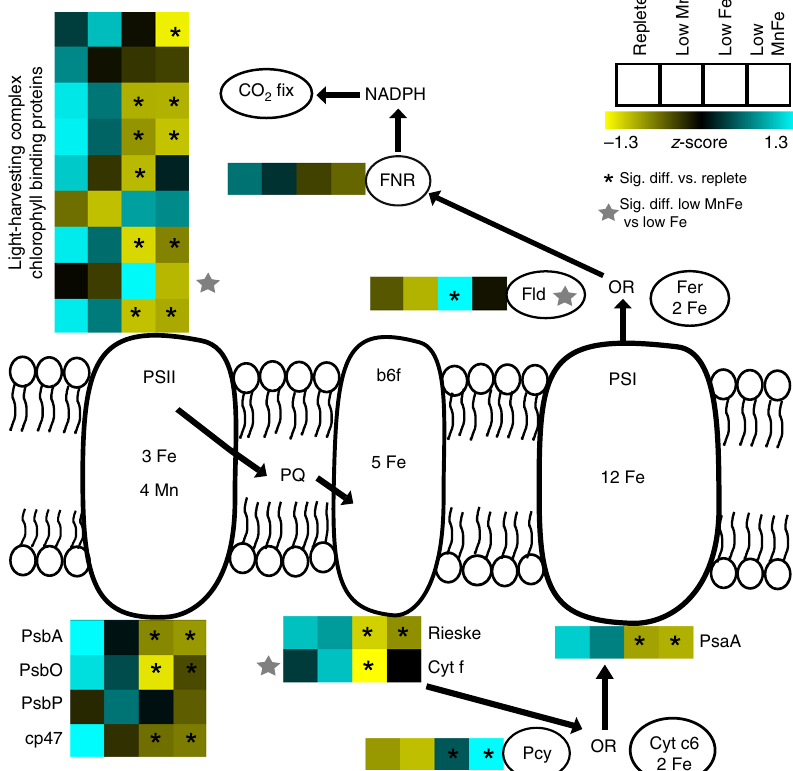
Fig. 3 Protein expression patterns in Phaeocystis antarctica photosystems. Expression patterns are shown under changing metal availability, with Phaeocystis grown at an irradiance level of 25 μ mol photons/m 2 /s. Mean standard ( Z ) scores shown for each detected protein involved in photosynthesis under replete, low iron (Fe), low manganese (Mn), and combined low Mn and low Fe conditions. These are displayed within a schematic representation of the photosystem shown with the number of metal ions per macromolecule 9,10 . Treatments signi fi cantly different to replete treatments are indicated with black asterisks; proteins differentially expressed between the low Fe vs. the low Mn and low Fe treatment are noted with a gray star. PsaA was detected and quanti fi ed using modi fi ed search and quanti fi cation procedures as described in Methods. Full protein names and source data are shown in the Source Data File. Signi fi cant differences were determined using empirical Bayes quasi-likelihood F test (with edgeR), where n = 3 biologically independent samples per